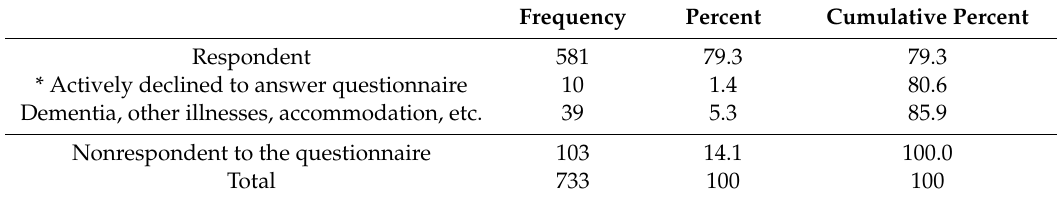
Table 1. Questionnaire dropout—the three first groups are included in the study